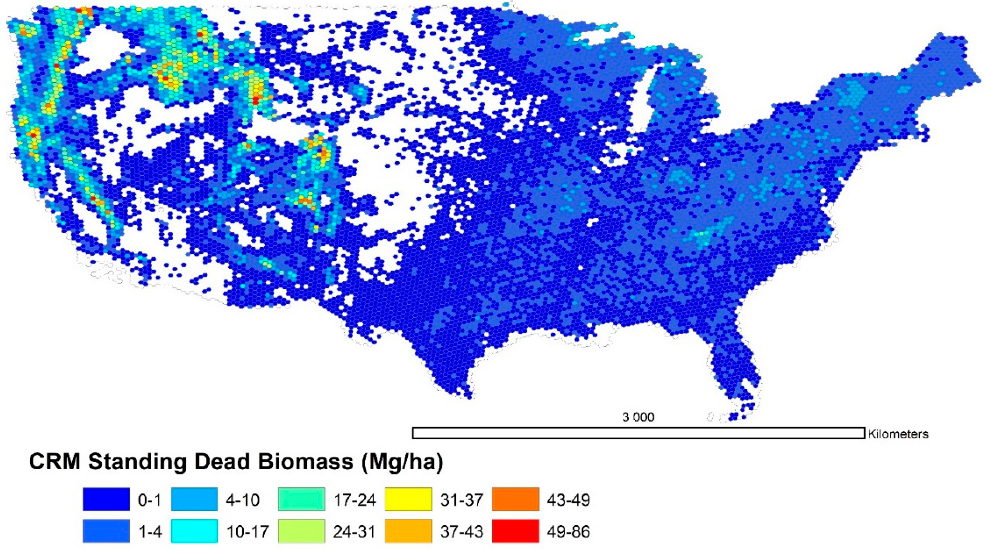
Figure 4. FIA hex-level estimates of CRM biomass of standing dead trees.